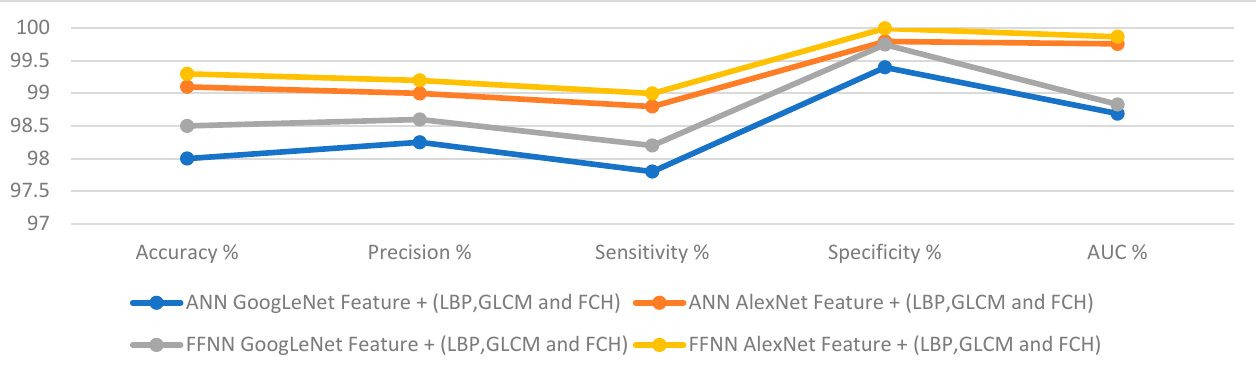
Table 7. Results of dataset evaluation by ANN and FFNN based on hybrid features.